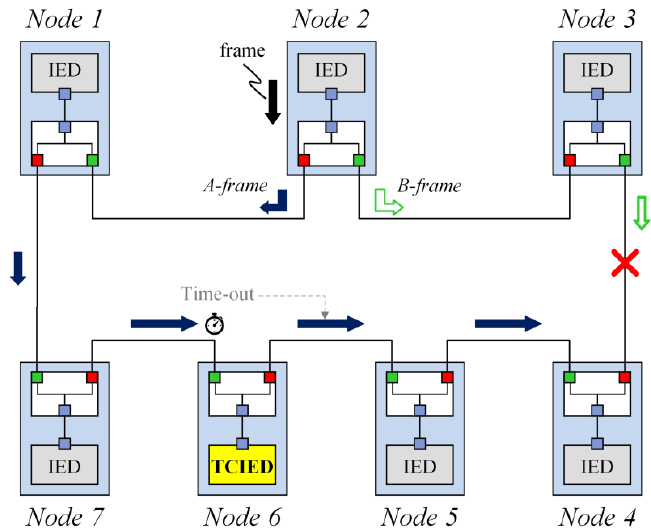
Figure 6. Forwarding frames in the failure case under the